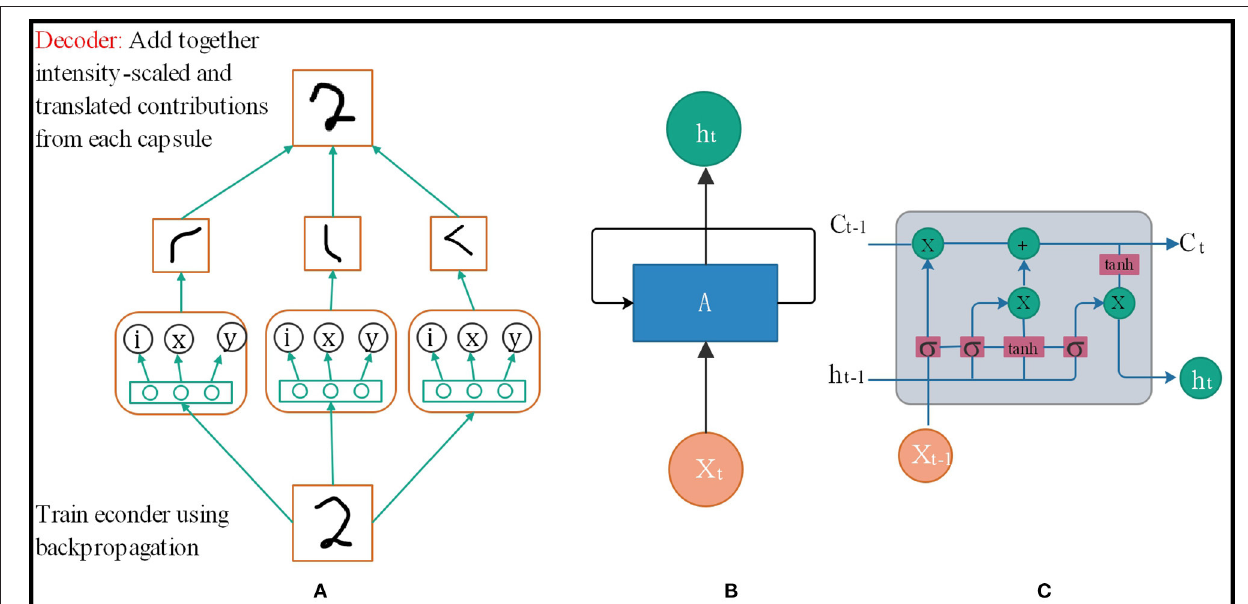
FIGURE 1 | (A) Capsule neural network structure. (B) RNN neural network structure. (C) LSTM neural network